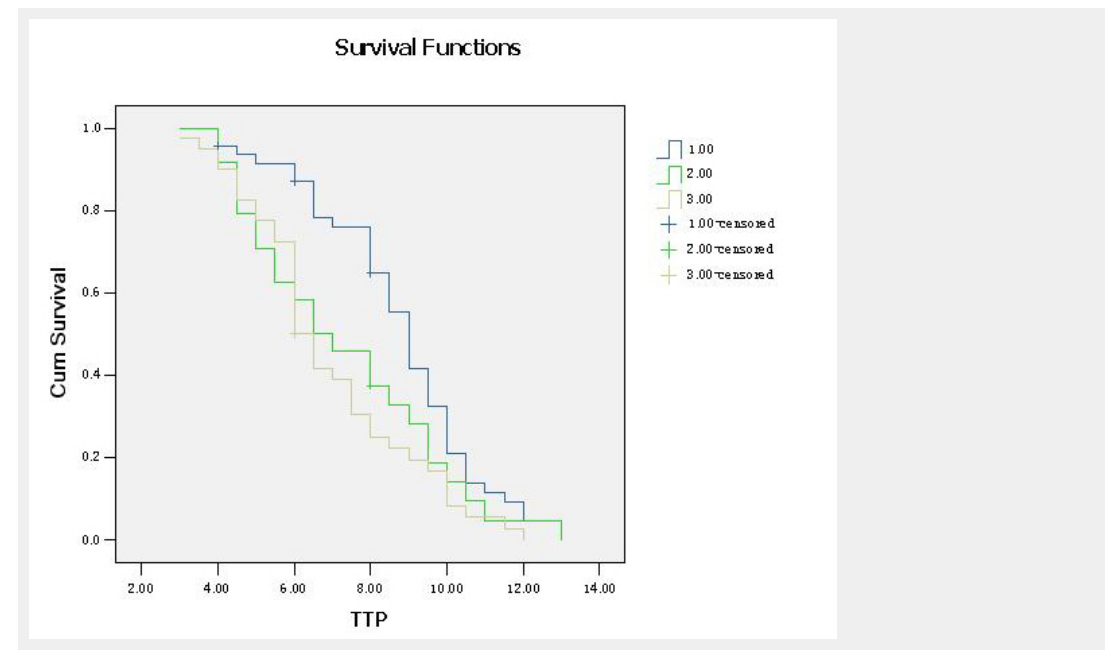
Figure 3 Association between the combination of GSTP1A313G and XRCC1G28152A polymorphisms (group 1: GSTP1 A/G+G/G and XRCC1 G/G genotype, group 2: GSTP1 A/G+G/G and XRCC1 G/A+A/A genotype, group 3: GSTP1 A/A and XRCC1 G/A+A/A genotype) and time to progression (TTP) in patients with advanced NSCLC receiving platinum- based chemotherapy. The vertical hash marks denote the time of last follow up for those patients lost to follow